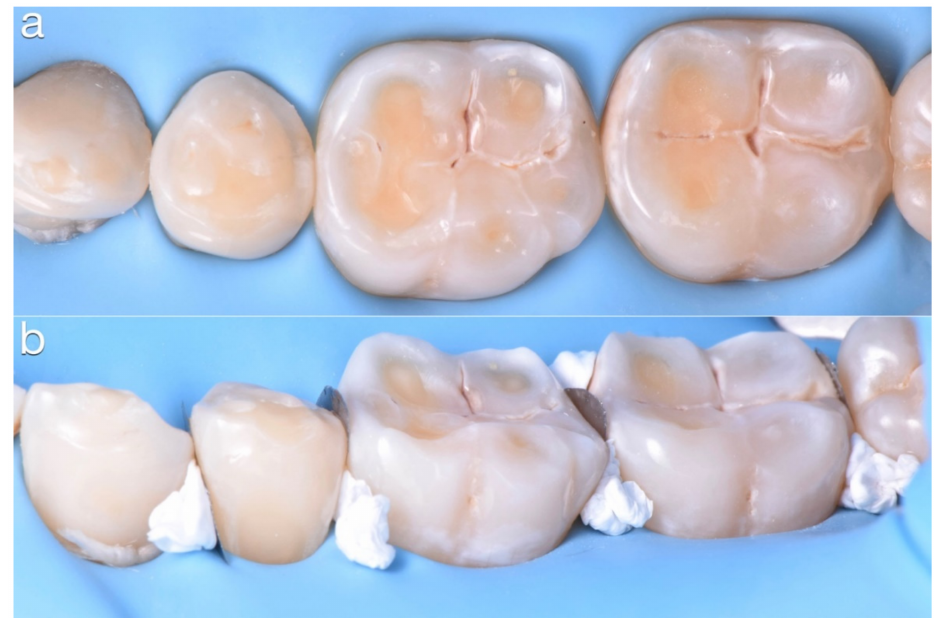
Figure 19. ( a ) Rubber dam isolation, ( b ) isolation of interproximal spaces with Teflon and customized matrix.